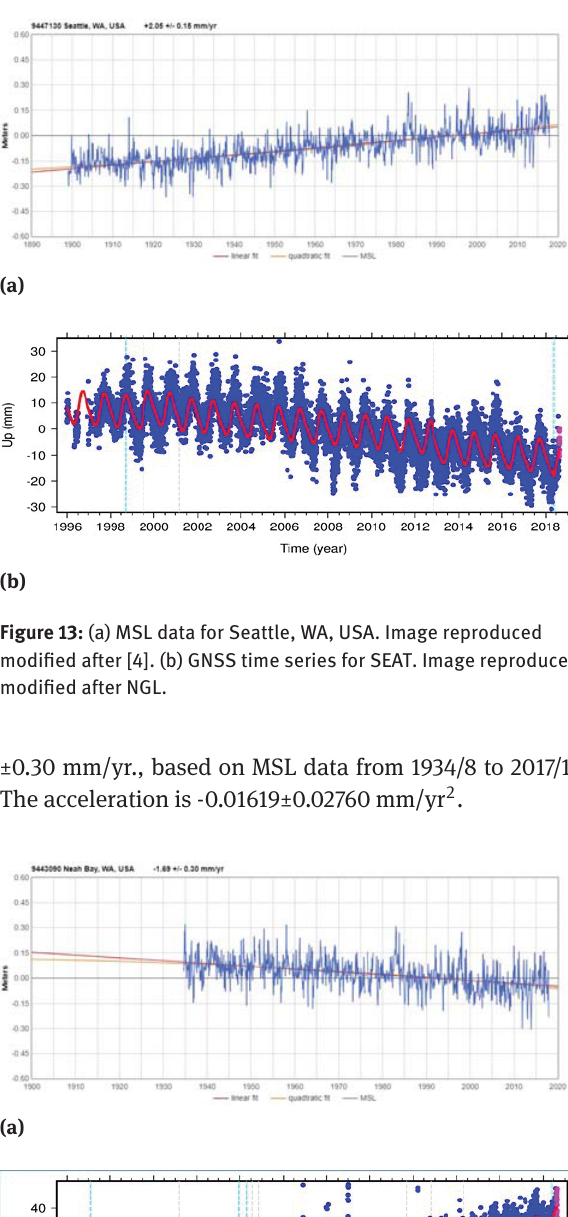
Figure 14: (a) MSL data for Neah Bay, WA, USA. Image reproduced modified after [4]. (b) GNSS time series for NEAH. Image reproduced modified after NGL.